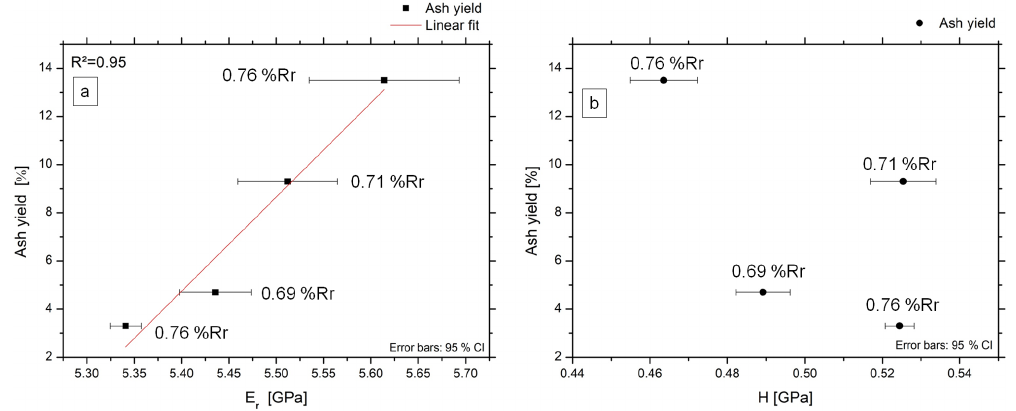
Figure 11. Correlation between ash yield (data from Sachsenhofer et al., 2003), E r (a) and H (b) of vitrinite macerals. Note that samples of equal maturity (and hence chemical composition) are displayed for comparison. (CI = Confidence